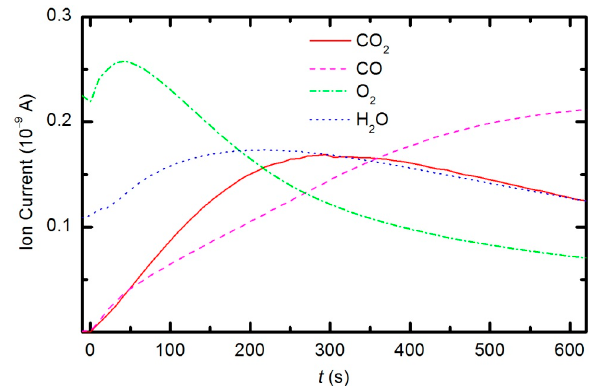
Figure 13. Time evolution of CO 2 , CO, O 2 and H 2 O partial pressures during samples treatment with oxygen plasma at 33 Pa and 150 W forward RF power.